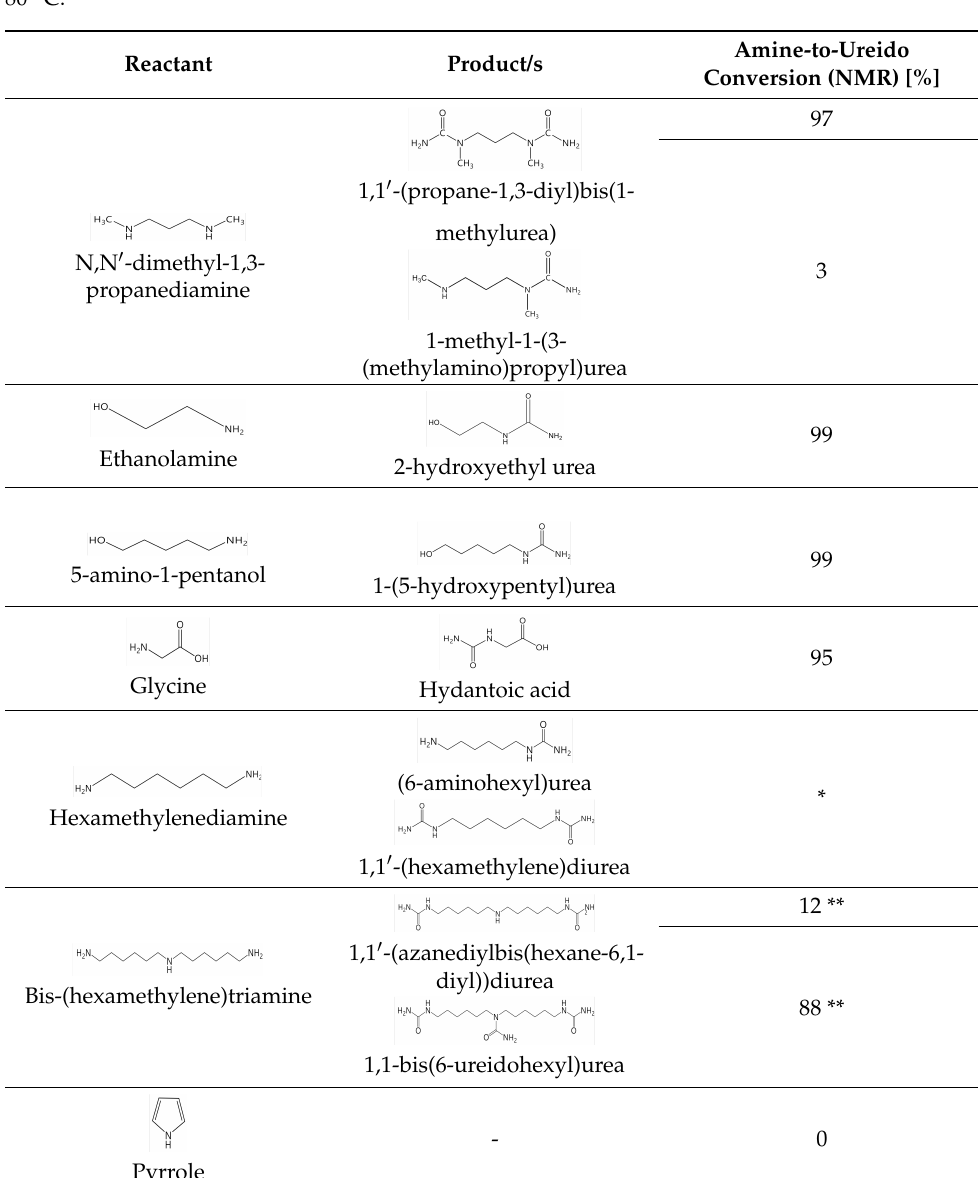
Table 1. Reactants, products and conversion of amine starting material after a 24 h reaction time at 80 ◦